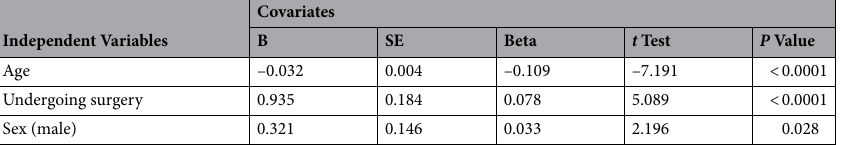
Table 5. Stepwise multiple regression analysis of absolute error of the AI at the C2–C7 angle as the dependent variable. The square of the coefficient of multiple correlation (R 2 ) in this model = 0.018. AI, artificial intelligence; B, partial regression coefficient; SE, standard error; beta, standardized partial regression coefficient.